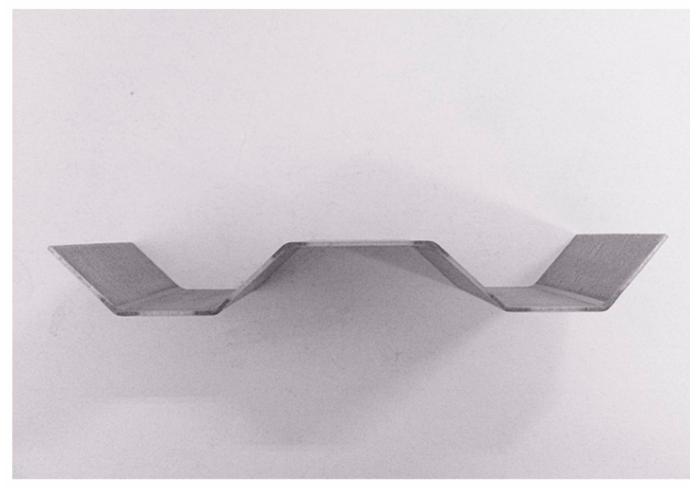
Figure 1. Two-period corrugated bulkhead